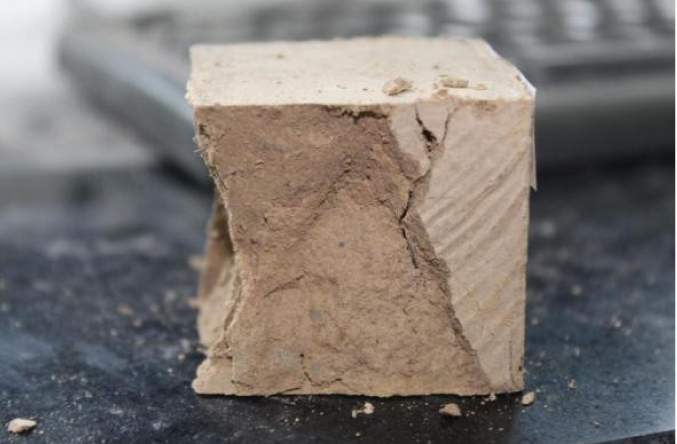
Figure 7. Fracture surface of conventional CSS